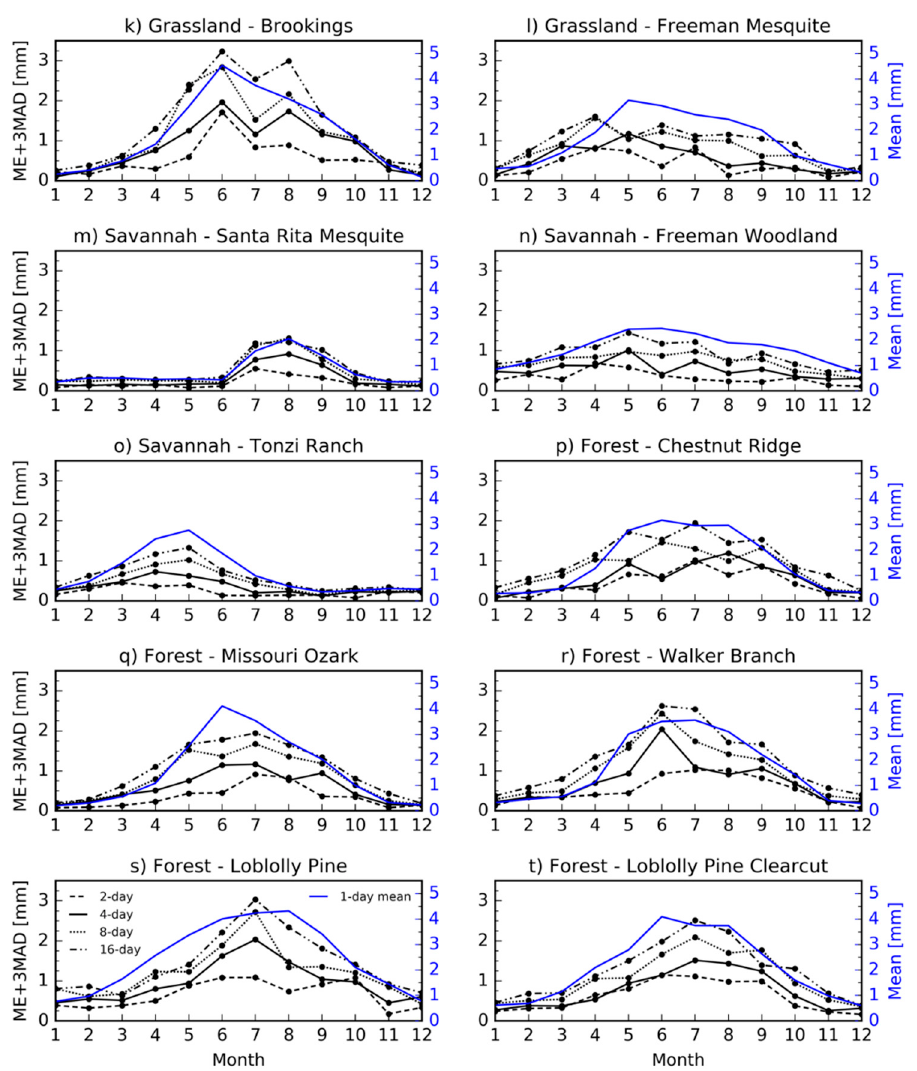
Figure 10. Maximum discrepancies (in mm per day)—expressed as the median error (ME) plus three median absolute deviations (MAD)—between the one-day revisit monthly ET dataset and four different revisit scenarios (2-day, 4-day, 8-day and 16-day revisit) for each site and a 13:00 simulated satellite overpass time. The blue line represents the ET monthly average (in mm per day) derived from the one-day revisit dataset.